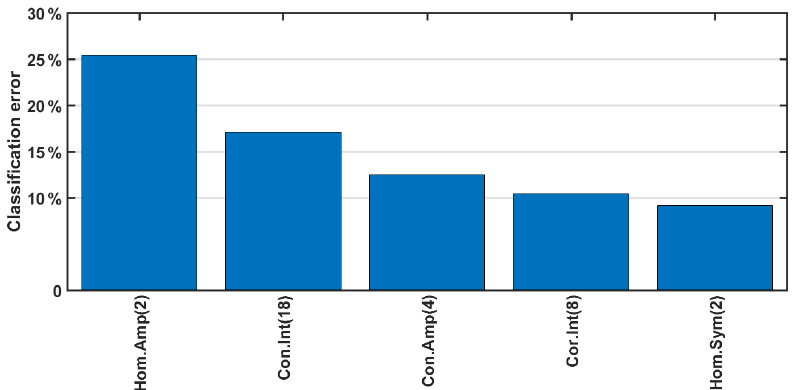
Figure 8. Parameters selected to minimize the classification error of the training ensemble by the QDA method. From left to right: amplitude of the homogeneity for the 2nd neighbour, integral of the contrast for the 18th neighbour, amplitude of the contrast for the 4th neighbour, integral of the correlation of the 8th neighbour and symmetry of the homogeneity for the 2nd neighbour.